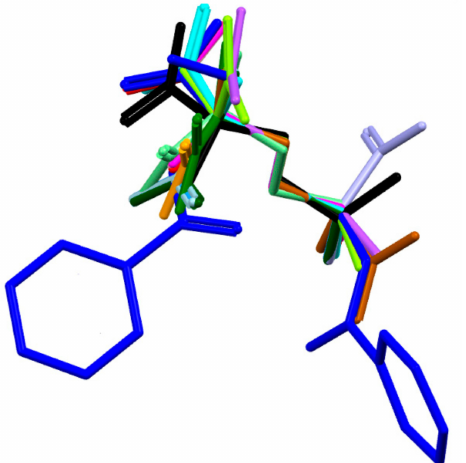
Figure 2. Overlay of the unique molecules in the crystal structures of 1 - dark blue, 2 - light blue and other ornithine derivatives known so far, such as: BAPKIP-light green, BAPKOV-magenta, BAPKUB-pink, BEZQOO-orange, BIHYEX- green, CAPRAM-violet, EVIJAU-red, GOTFAY-cyan, JADGED-black, ORNBDL10-lavendae, TEFMIA-light brown, VUYHII-blue, YIGMAE-light green, PUYVUA-dark green. H-atoms are omitted for clarity. CSD reference codes are described in the Section 3.3.